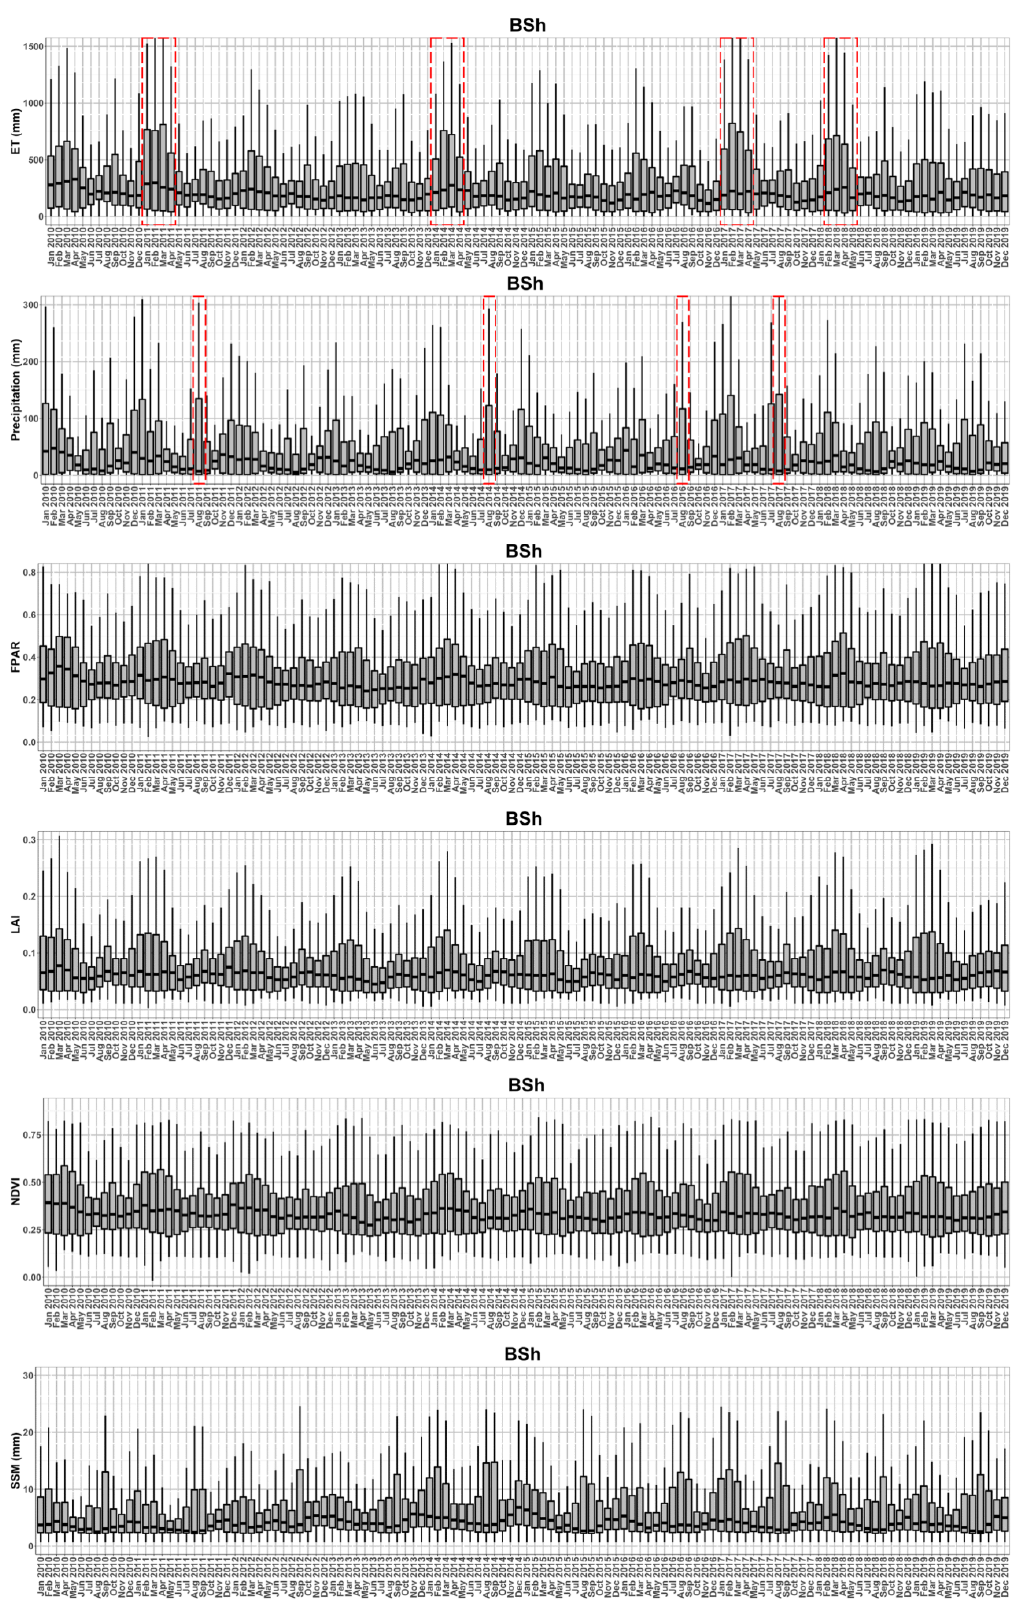
Figure 2. The time series boxplots of evapotranspiration (ET), precipitation, fraction of absorbed photosynthetically active radiation (FPAR), Leaf Area Index (LAI), Normalized Difference Vegetation Index (NDVI) and surface soil moisture (SSM) between 2010 and 2019 for BSh.